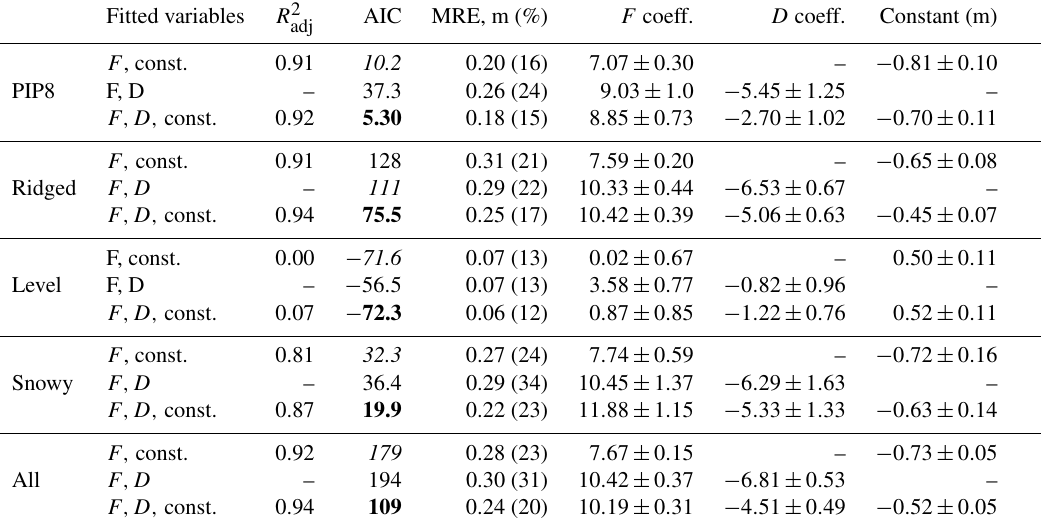
Table 3. Fitted coefficients for SIT T as a multilinear regression of the snow freeboard F and snow depth D (Sect. 3.2.2), and also fitting for F only (Sect. 3.2.1). The variable “const.” refers to a constant term being included in the fit. Surfaces are also categorized (Fig. 7) to incorporate roughness into the fits (Sect. 4.1.3). As the R 2 is not well-defined for a fit with no constant term, the Akaike information criterion (a metric that minimizes information loss) is used to compare the models (Akaike, 1974). The R 2 is reported for the with-constant fits only and is adjusted for the different sample sizes in each fit. For each dataset, the smallest AIC value is bolded, and the second-lowest is italic. The absolute value of the AIC does not matter; only the relative differences between AICs for different models that use the same dataset matter, with the lowest being the best model. For individual floe fits, only PIP8 is shown for brevity as the other floes have comparable errors and